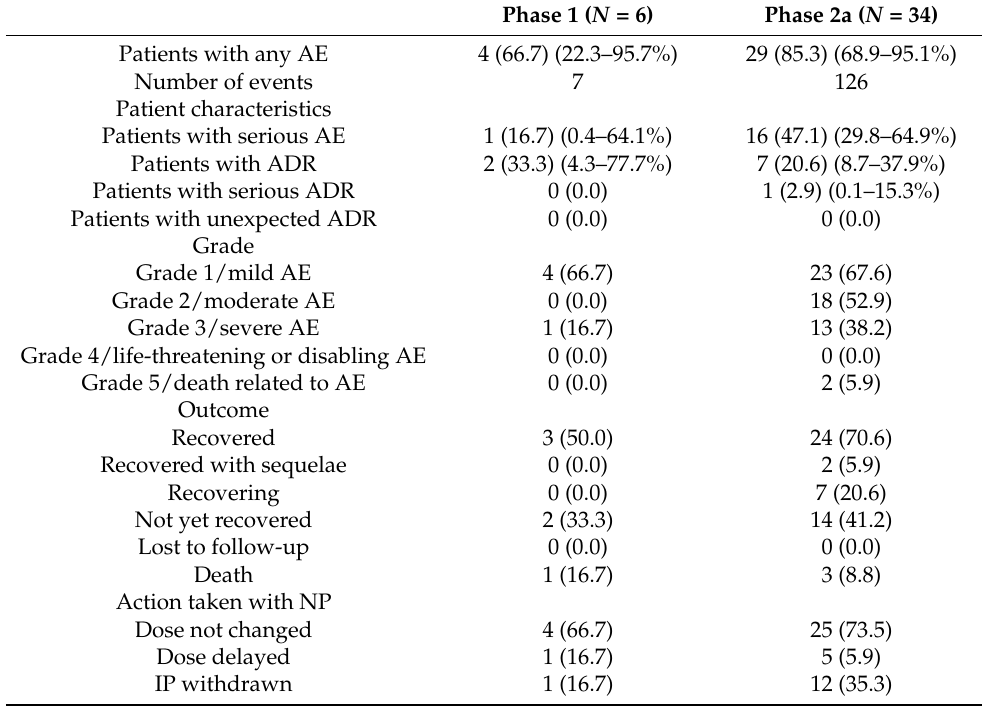
Table 2. Summary of the adverse events and adverse drug